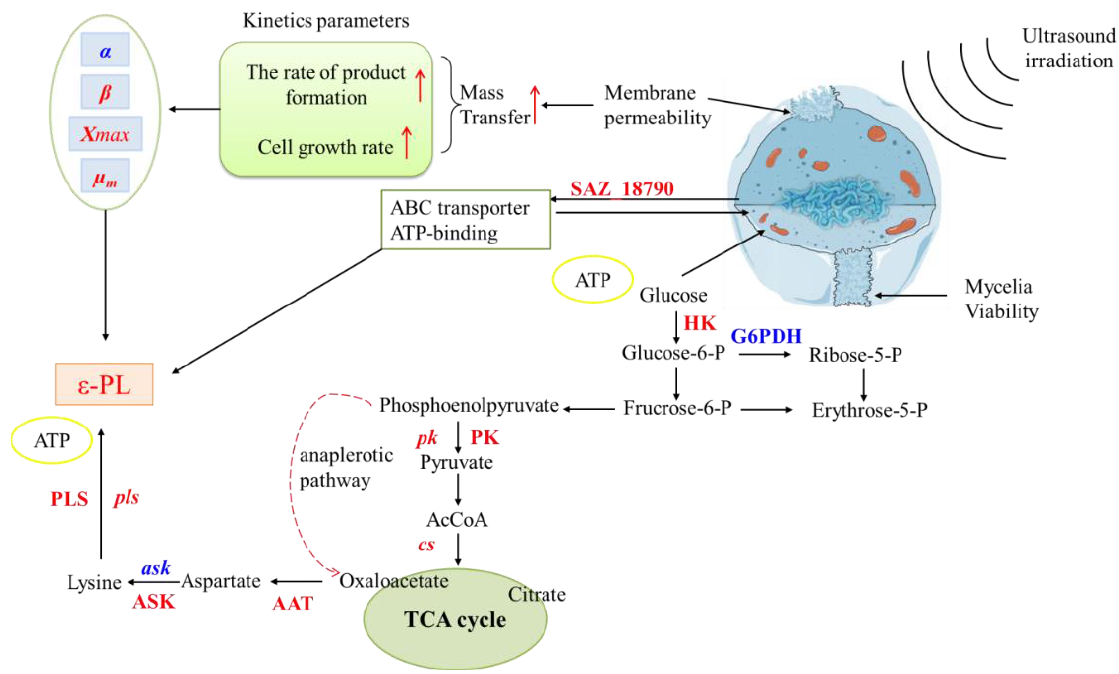
Figure 8. The proposed pathway of ultrasound-enhanced actinomycetes mycelia metabolism and ε -PL production from S. albulus in a 3-L-jar fermenter. (Lowercase letters a, b indicate that there is a significant difference between the different ultrasound-treated culture times of fermentation ( p < 0.05)).